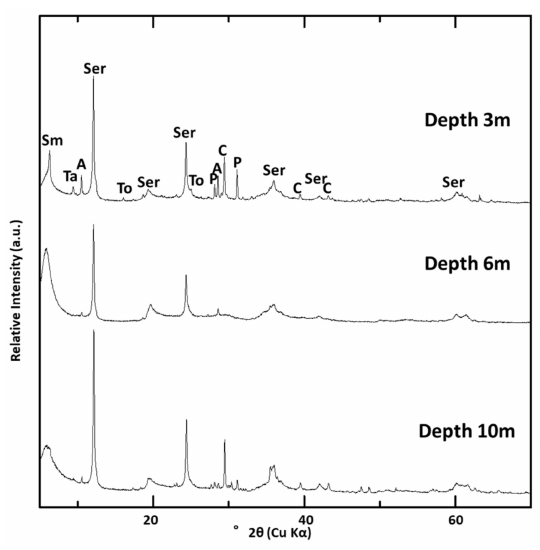
Figure 4. XRD traces of randomly oriented powder samples of DH4 at three depths (3, 6 and 10 m). Sm: smectite; Ser: serpentine; To: tobermorite; Ta: talc; P: pyroxene; A: amphibole; C: calcite.